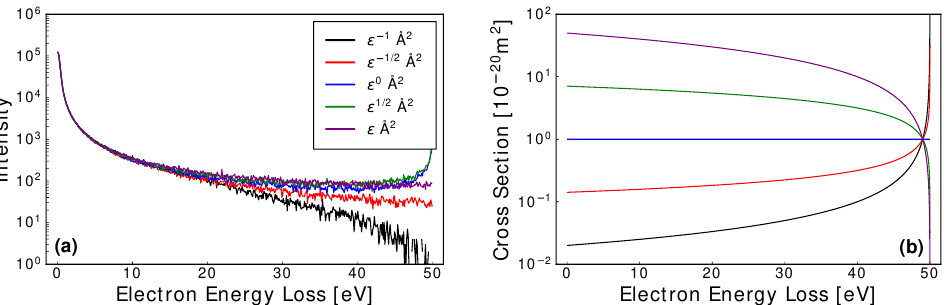
Figure A2. Electron Energy Loss Spectra ( a ), and their corresponding elastic cross-sections ( b ), for various power laws (see legend of ( a )). An initial energy of 50 eV was used. Each spectrum initially remains the same between each power law, before a divergence is observed at higher energy loss. Each spectrum for a single cross-section remains independent of the cross-section magnitude; however evident here is a dependence upon each cross-section derivative.